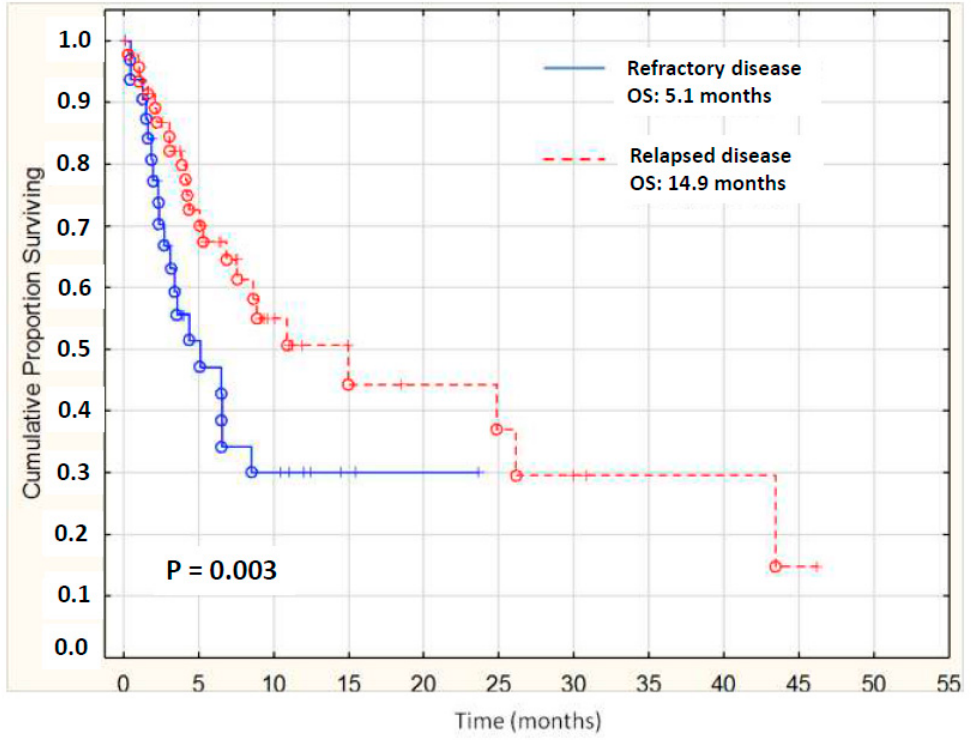
Figure 3. Survival from relapse of 79 AML elderly patients treated with hypomethylating agents (HMAs); median of relapsed patients was significantly higher than refractory ones (14.9 vs. 5.1 months).